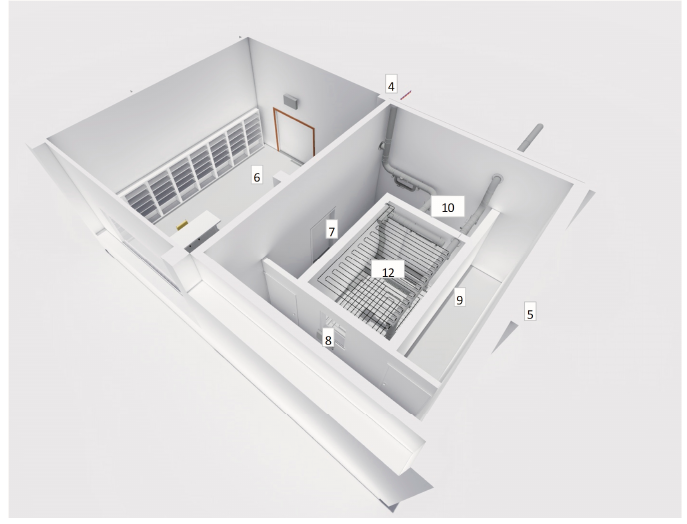
Figure 12. Schema of the Indoor Environment Quality laboratory, University of Debrecen.